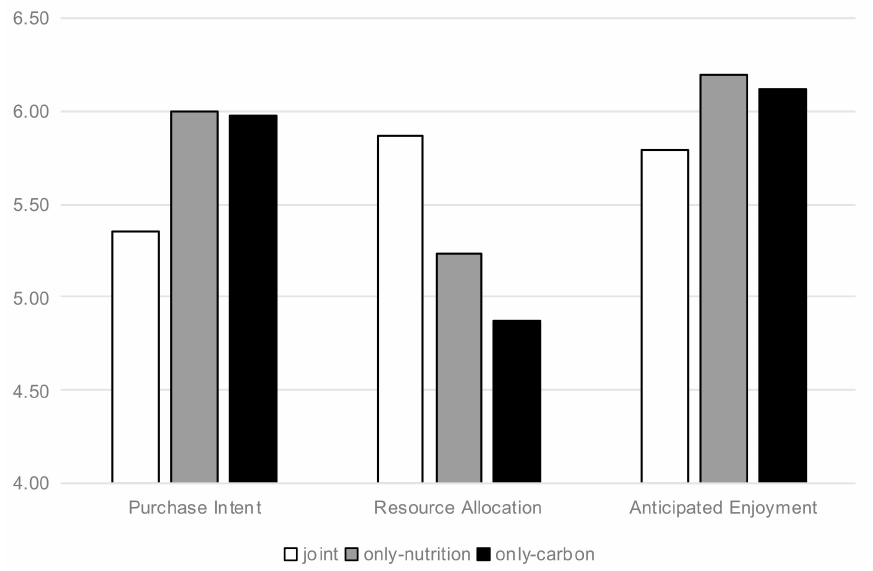
Figure 3. Backfire on the effect of labels on purchase intention, resource allocation, and anticipated enjoyment (Ice